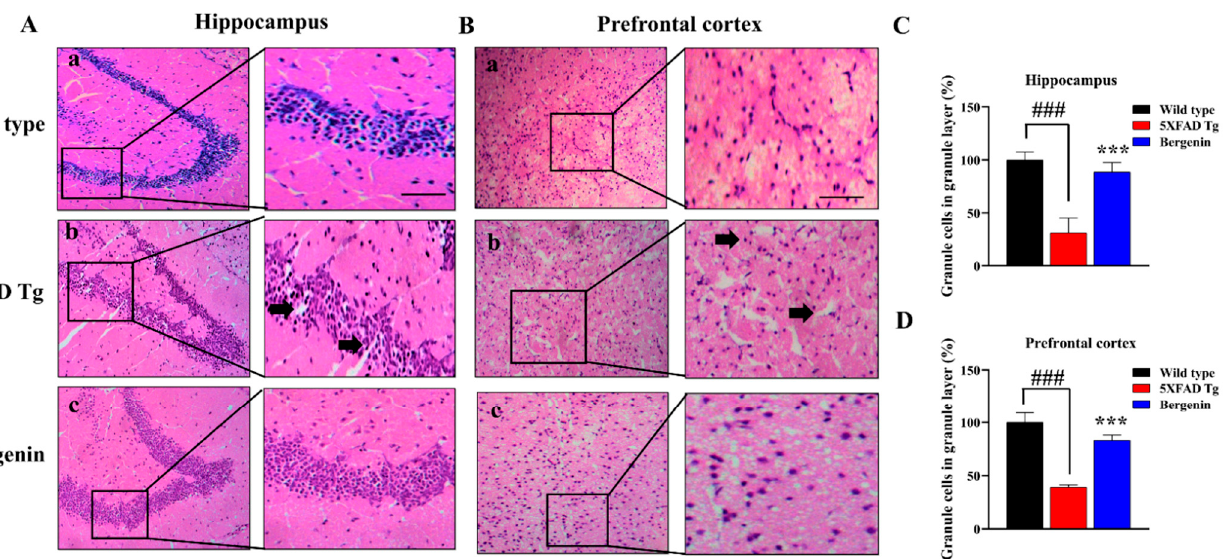
Figure 4. Representative photomicrographs of hematoxylin and eosin (H&E) stained hippocampal and prefrontal cortex region in ( a ) wild-type, ( b ) 5xFAD Tg, and (c) Bergenin groups. ( A ) Bergenin (60 mg/kg) displayed a regular density of granule cells with well-stained nuclei (arrows) in the hippocampal region while: ( B ) it prevented neuronal damage and poorly stained nuclei (arrows) in the prefrontal cortex. Scale bar = 50 µ m. Quantitative analysis was done in ( C ) hippocampal and ( D ) prefrontal cortex region, results were expressed as mean ± S.D. *** p < 0.001 versus the 5xFAD Tg group, ### p < 0.001 versus the wild-type group.